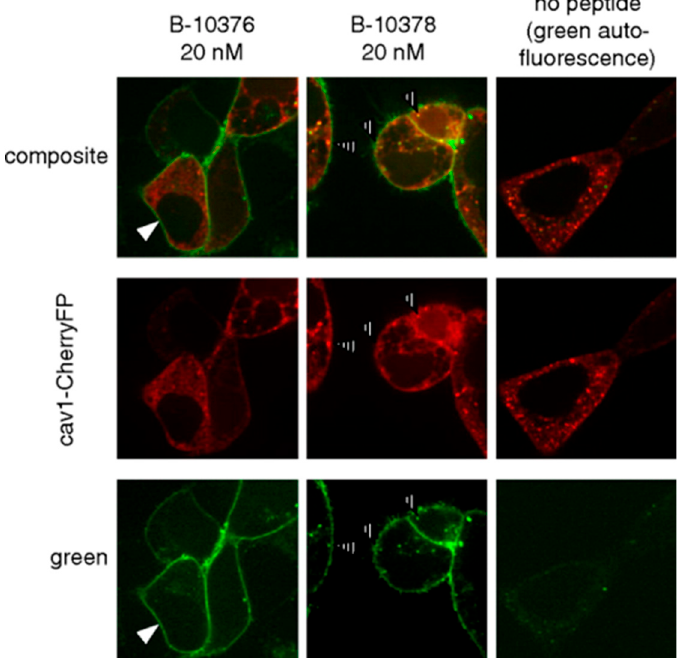
Figure 5. Confocal fluorescence imaging in HEK293a cells transiently expressing rabbit B1R and cavelolin-1-CherryFP. Cells were treated with 20 nM B-10376 (antagonist) or B-10378 (agonist). Both peptides labeled plasma membrane, but cells treated with B-10378 displayed enhance punctate fluorescence condensation that colocalized with cavelolin-1 indicated by hashed arrows. Figure reproduced from Bawolak, M.T.; et al. [72].